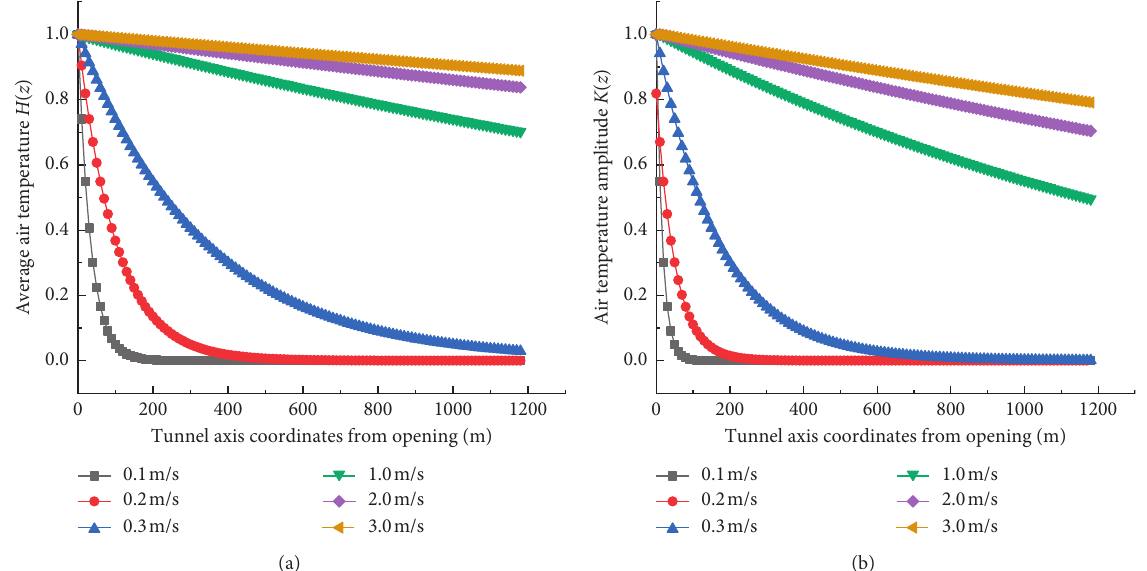
Figure 7: Temperature variation curve in the longitudinal direction under different velocities: (a) the average temperature function, H ( z ), in the tunnel; (b) the temperature amplitude function, K ( z ), in the tunnel.